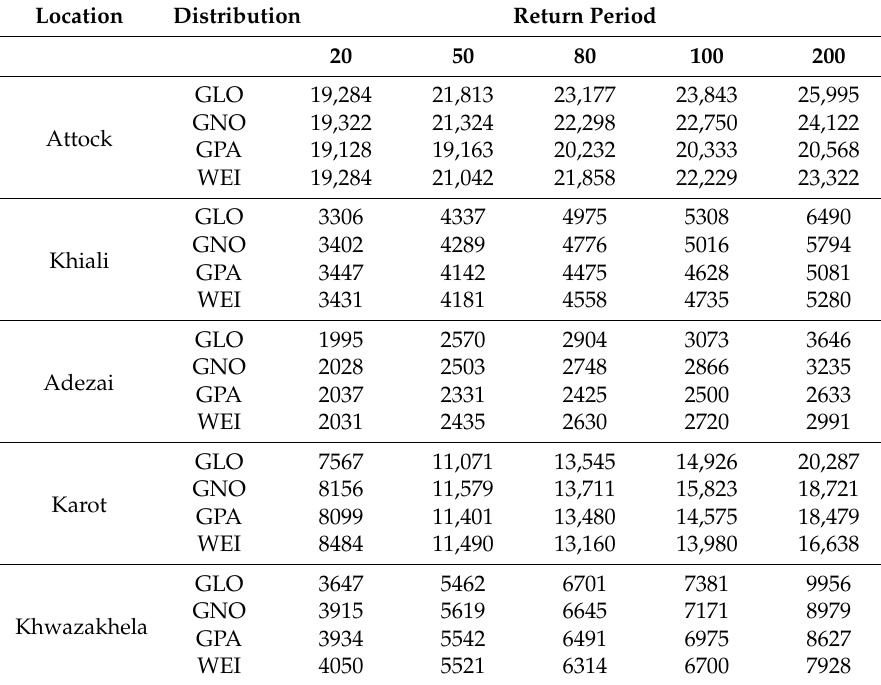
Table 7. Flood quantiles estimated by different PDs in